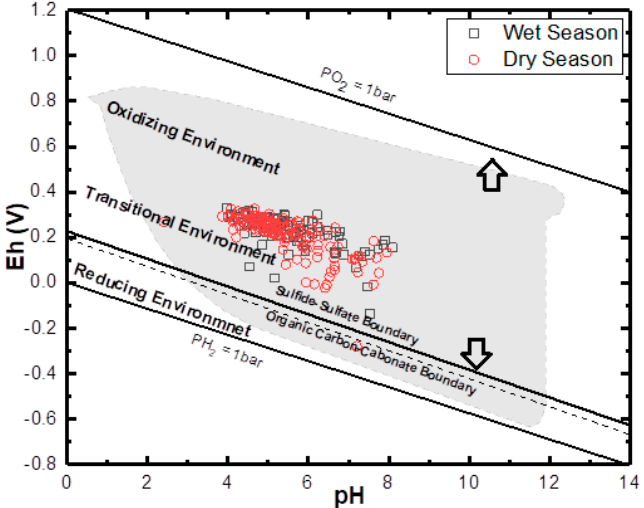
Figure 12. General Eh-Ph diagram for both wet and dry season groundwater samples. The upper and lower stability limits of water are given where PO 2 and PH 2 = 1 bar. The dry season shows more extensive variation in the thermodynamic phase, while both are generally plotted within the transitional phase .